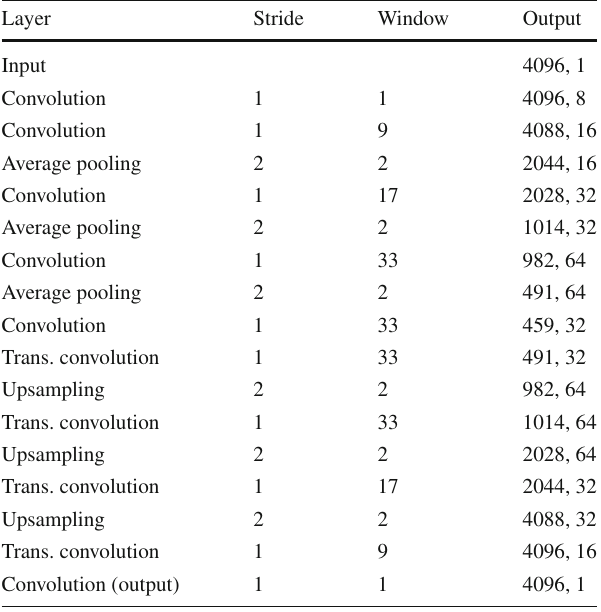
Table 2 Summary of the convolutional autoencoder architecture used in this paper for a fixed pulse size of 4096. Included in this table is the type, strides length S , window size K , and output shape O of each